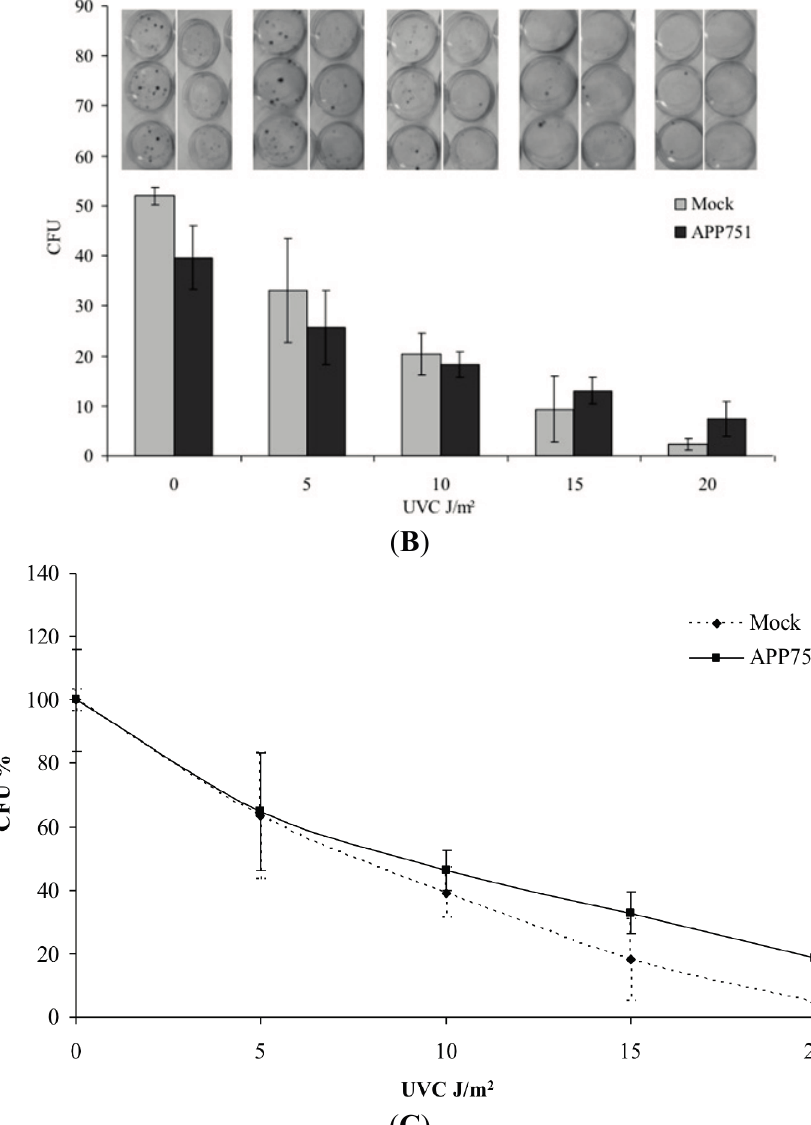
Figure 1. UVC cytotoxicity at short and long-term. Mock and APP751-expressing cells were cultured 48 h prior to irradiation. Then, four doses of UVC 5, 10, 15 and 20 J/m 2 were tested. For short-term cytotoxicity, cells were grown for additional 24 h and then the MTT assay was performed to assess cell viability ( A ). Significance was assessed through the Student t -test ( n = 3). * Data significantly different from mock cells ( p < 0.05); For long-term toxicity, the cells were grown for an additional 12 days and then the colonies were revealed using crystal violet, and manually counted. The bar graph represents the number of colony forming units (CFU) in relation to the dose used; a representative picture of petri dishes following revelation with crystal violet is given above each bar of the graph, corresponding to each tested condition in triplicate ( B ); ( C ) represents the evolution of CFU in percentage Significance assessed through the Student t -test ( n =